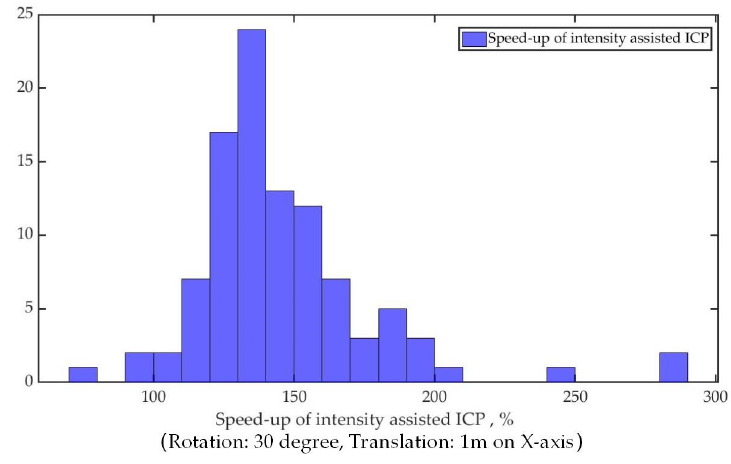
Figure 10. The intensity-assisted ICP speed-up relative to the conventional ICP.